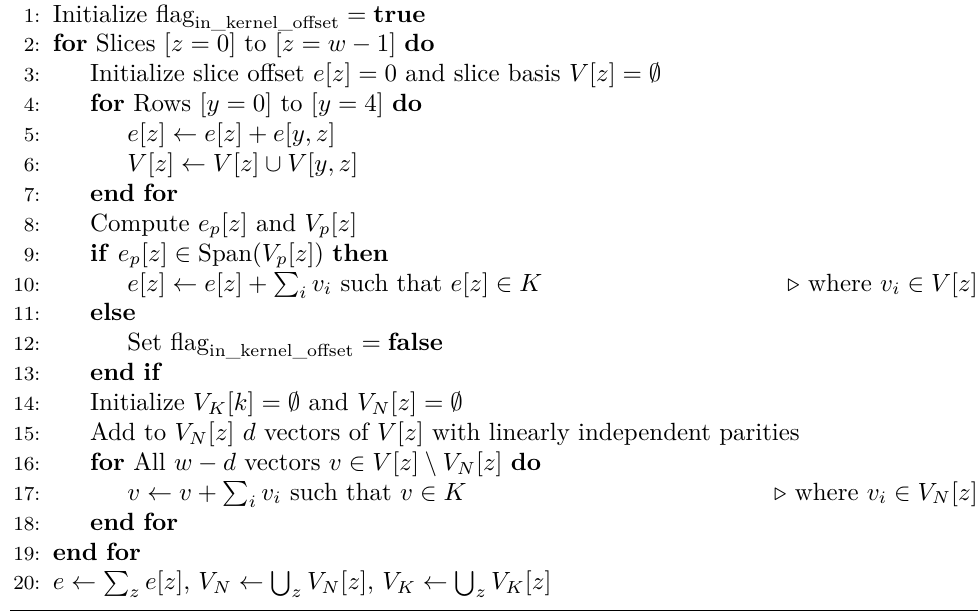
Algorithm 2 Offset and basis creation with separation between in-kernel and outside- kernel vectors